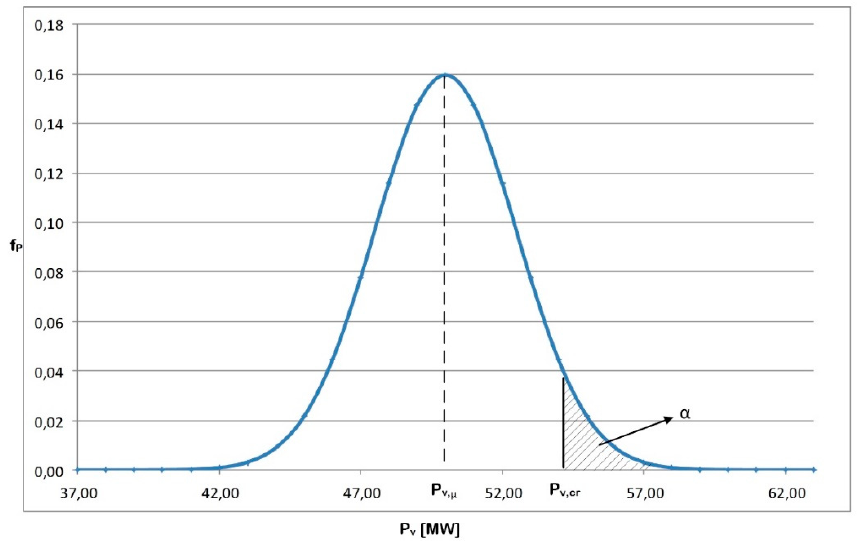
Figure 5. An example of the probability distribution of WPP production forecast error.